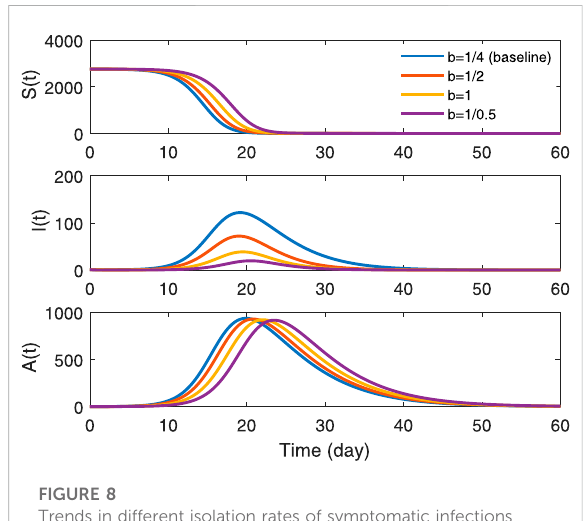
FIGURE 6 Trends in different transmission rates in groups S ( t ), I ( t ) and A ( t ).Thesolidbluelinerepresents β =1.888,whichistheestimated value in data type B-7. The red line indicates β = 1.4, the yellow denotes β = 1.0, the purple denotes β = 0.8.